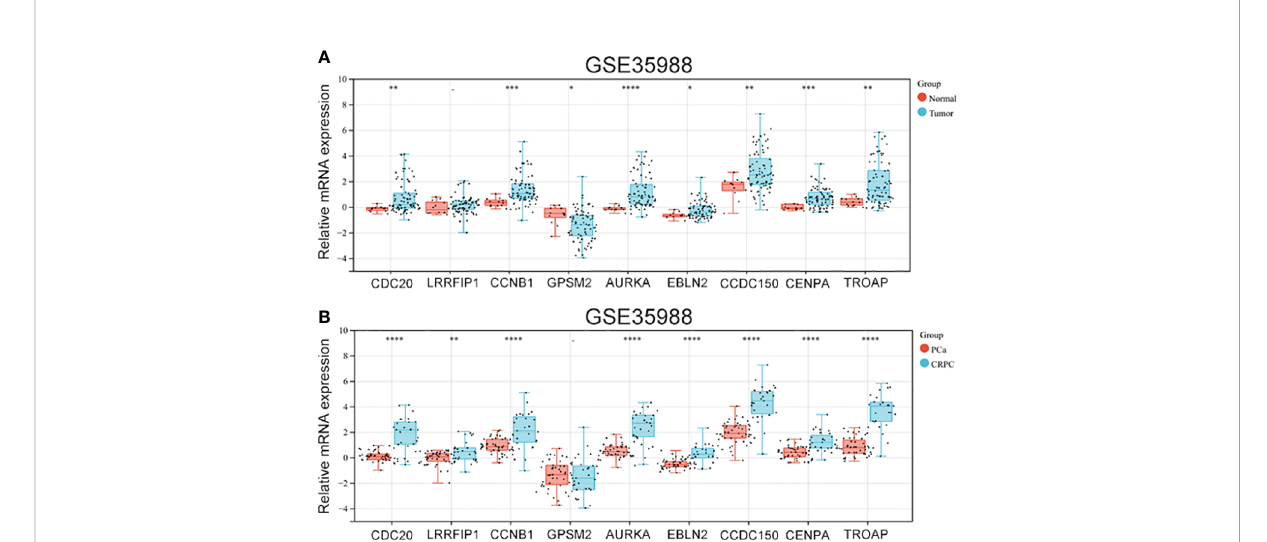
FIGURE 5 The expression of vinblastine resistance-related genes in GSE35988 datasets. (A) The expression of nine vinblastine resistance-related hub genes between normal and tumor samples from GSE35988. (B) The expression of nine vinblastine resistance-related hub genes between PCa and CRPC samples from GSE35988. – represents no statistical differences. * represents P <0.05, ** represents P <0.01, *** represents P <0.001, **** represents P